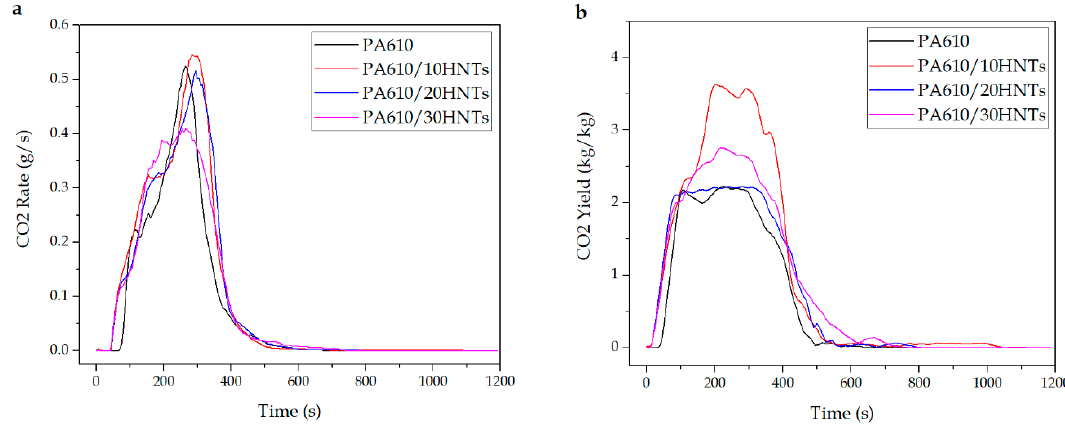
Figure 3. CO 2 production during the CCT test: ( a ) CO 2 rate and ( b ) CO 2 yield.